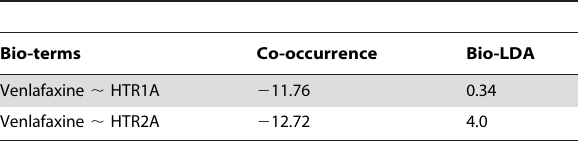
Table 7. Calculated association score for Venlafaxine and HTR1A,